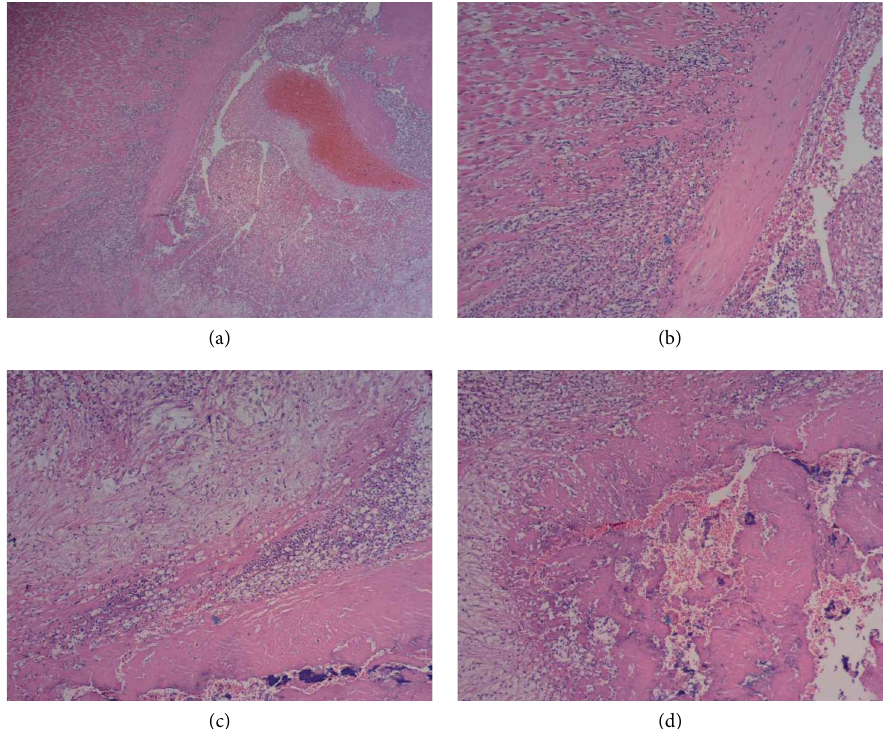
Figure 3: Aortic valve leaflets and myocardium are depicted. Severe diffuse acute suppurative endocarditis and myocarditis is shown (a, original magnification 10x). Separating, surrounding and replacing cardiomyocytes, there are numerous degenerate karyorrhectic neutrophils, a moderate number of erythrocytes, eosinophilic cellular, and karyorrhectic debris (necrosis) and small, basophilic, rod-shaped, 0.5 × 1 µ m bacterial aggregates (b, c, d, original magnification 40x) (hematoxylin and eosin stained, formalin fixed-paraffin embedded tissue